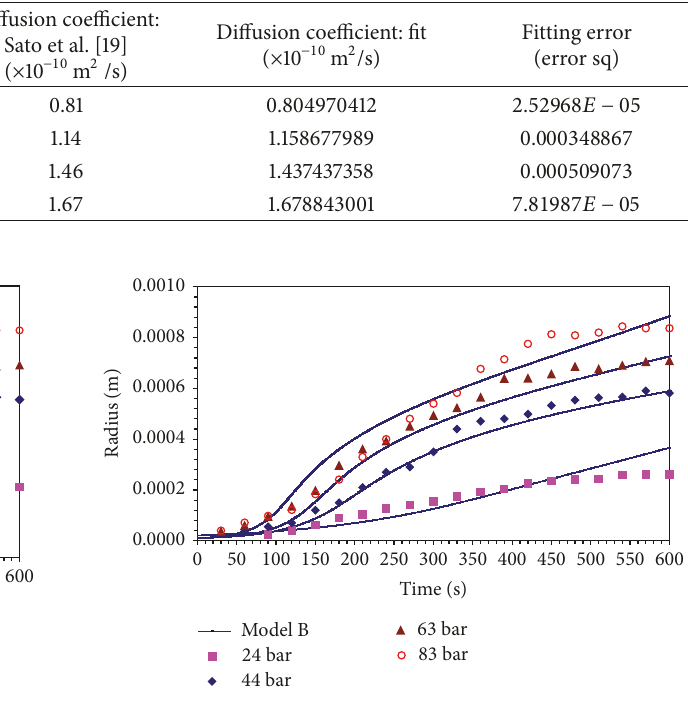
Figure 18: Model B versus experimental data for bubble growth at 100 ∘ C.